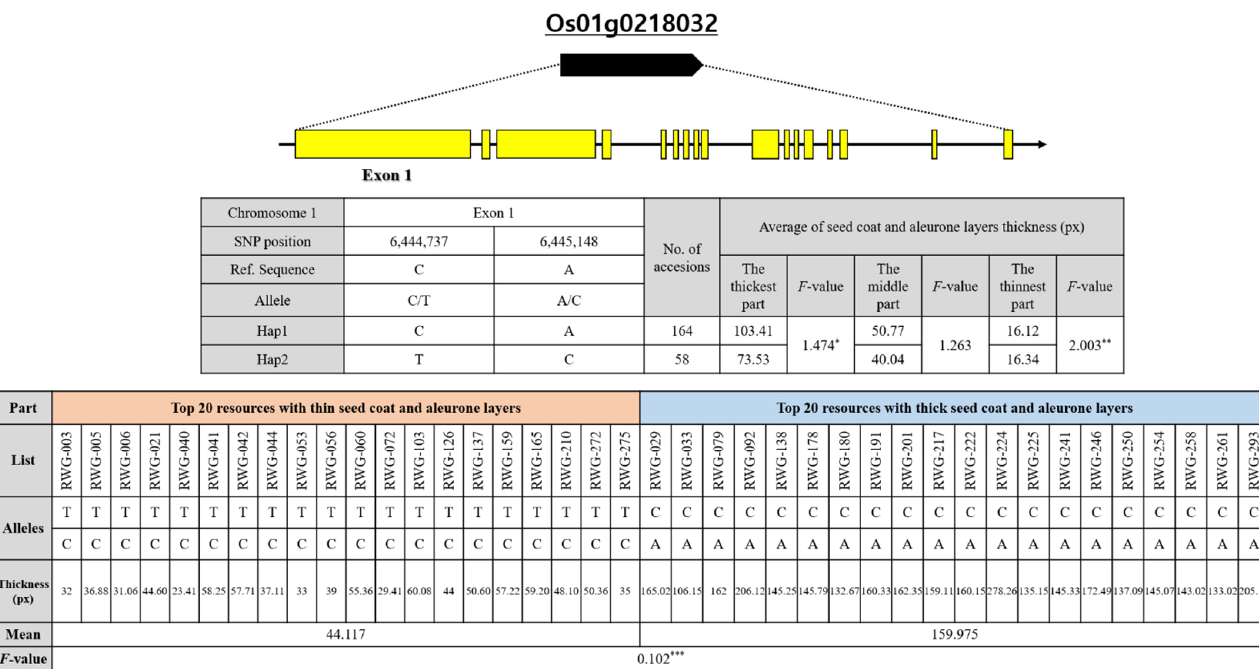
Figure 7. Haplotype analysis of the sequence covering the candidate gene Os01g0218032 on chromosome 1 coding regions in the 294 rice core collection and the phenotypic variation among different haplotypes. *, significant difference at p < 0.05; **, significant difference at p < 0.01; ***, significant difference at p < 0.001.